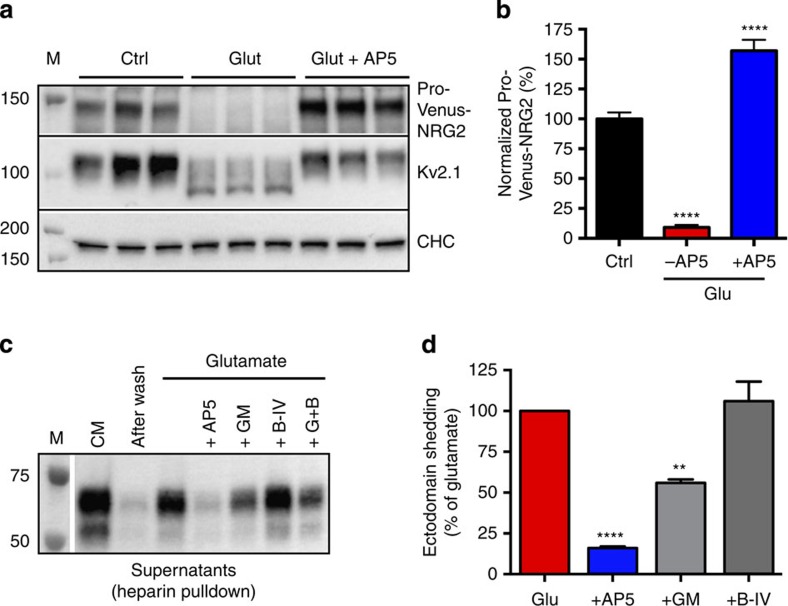
NMDAR activation triggers NRG2 ectodomain shedding.(a) Pro-Venus-NRG2 in whole-cell lysates of DIV 21 hippocampal neurons, stimulated for 20 min with 20 μM glutamate in the absence or presence of 50 μM AP5. Kv2.1 protein is shown to illustrate the characteristic downward shift in electrophoretic mobility in response to glutamate37. Clathrin heavy chain (CHC) is included as a loading control. (b) Quantitative analysis of pro-Venus-NRG2 downregulation by glutamate. Data are normalized to untreated controls. N=13 (Ctrl), 12 (Glu) and 8 (Glu+AP5) from six independent experiments. (c,d) Glutamate triggers NMDAR- and alpha-secretase-dependent NRG2 ectodomain shedding. Western blot in (c) shows Venus-NRG2 ectodomain protein in conditioned medium (CM), after replacement of CM with CM from uninfected cells, and after 20 min of 20 μM glutamate. Dependence of ectodomain shedding on NMDAR- and alpha-secretase activity revealed by pretreatment of cells with 50 μM AP5 and 10 μM GM6001, respectively. By contrast, ectodomain shedding was not affected by the inclusion of the beta-secretase inhibitor BACE-IV (1 μM). (d) Quantitative analysis of Venus-NRG2 ectodomain. Data are normalized to glutamate. N=3 independent experiments. Data represent the mean±s.e.m. **P<0.01; ****P<0.0001 (one-way analysis of variance). Ctrl, control; Glut (or Glu), glutamate.